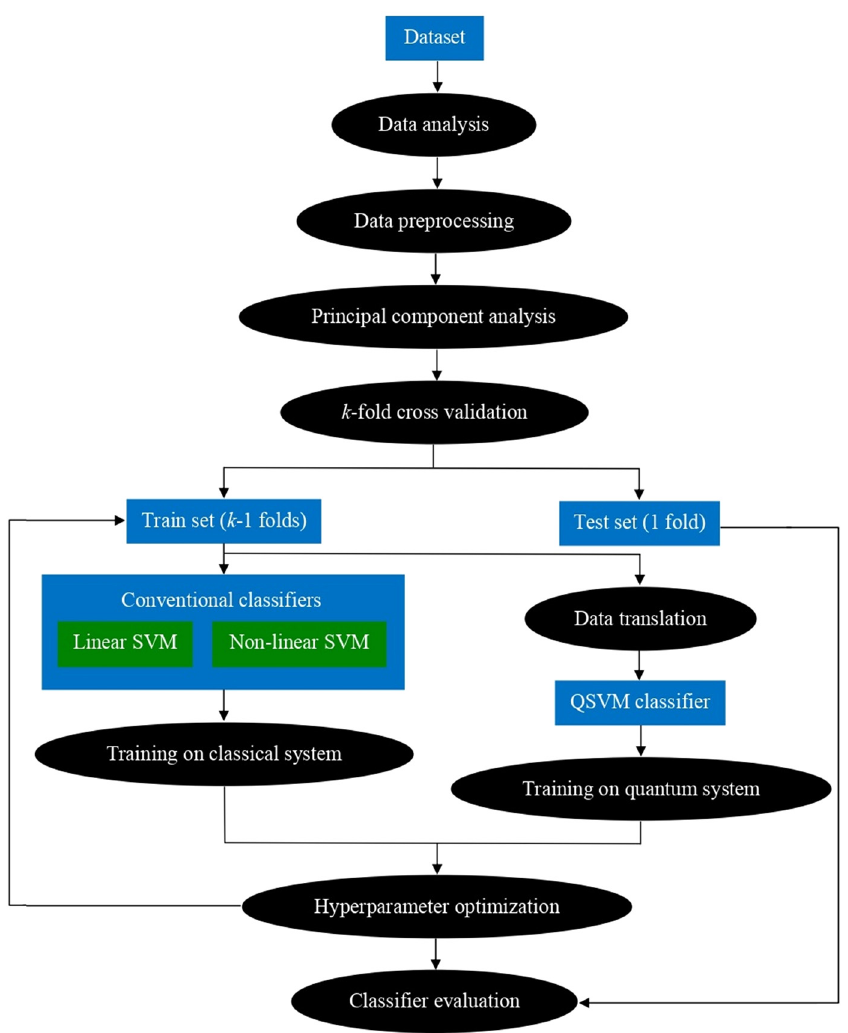
Figure 1: Object process diagram of constructing, training, and testing the SVM classi fi